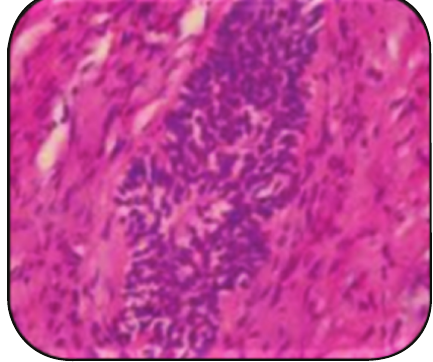
Figure 7: Histopathology.